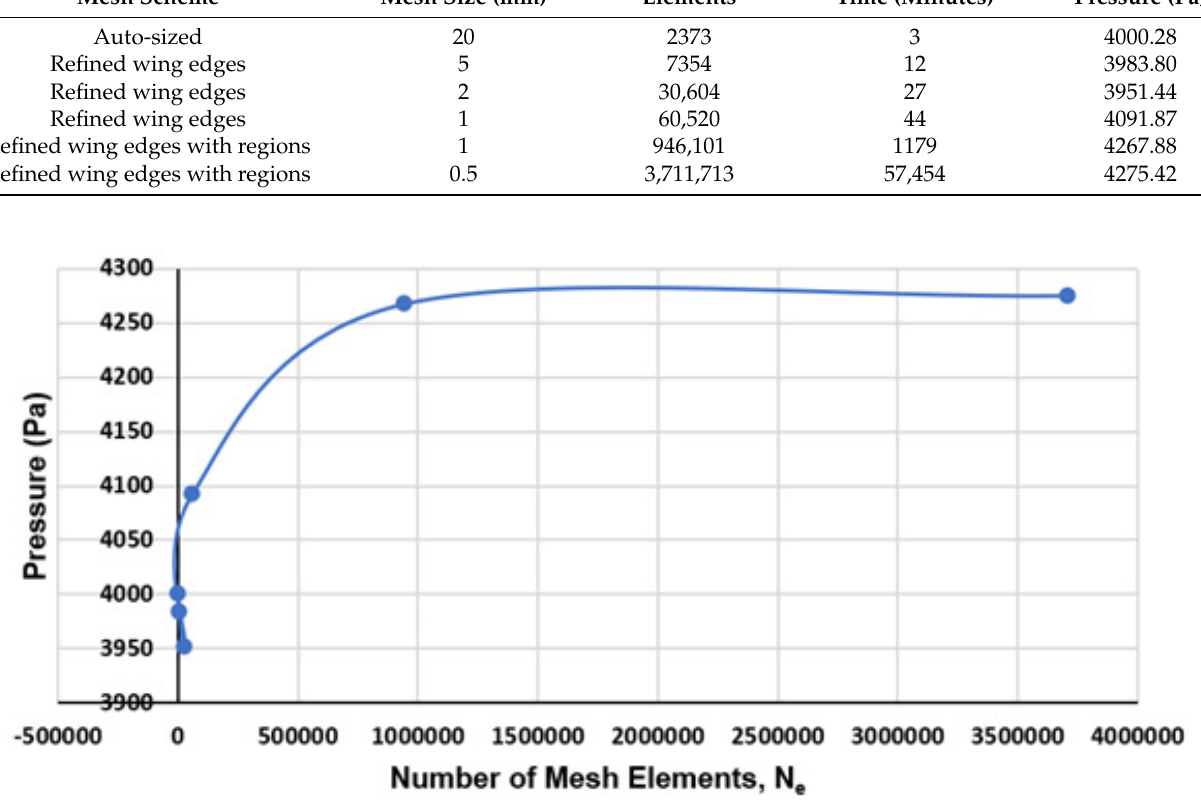
Figure 8. Mesh convergence study for stabilization of pressure as number of elements increases in 2D.